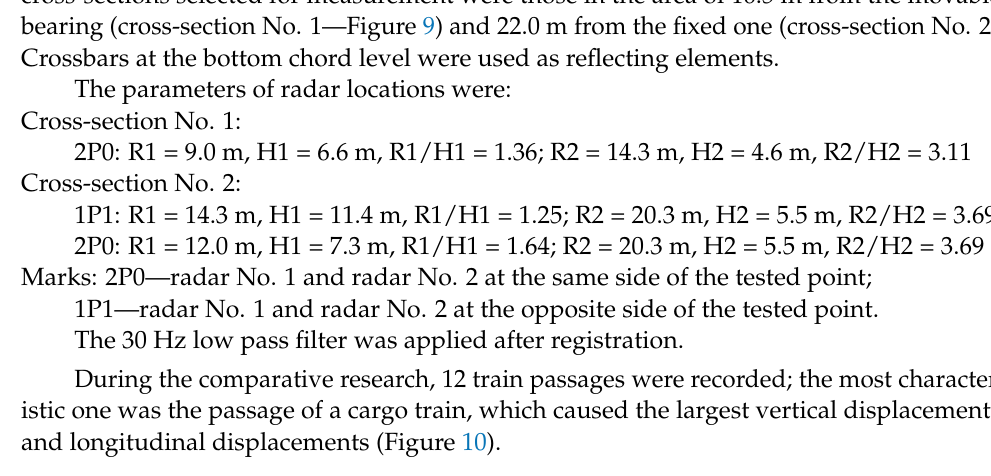
Figure 9. Bridge No. 1—test at cross-section No. 1: ( a ) 1—radar No. 1, 3—inductive transducer for the reference measurement; ( b ) 1 and 2—radar No. 1 and No. 2.